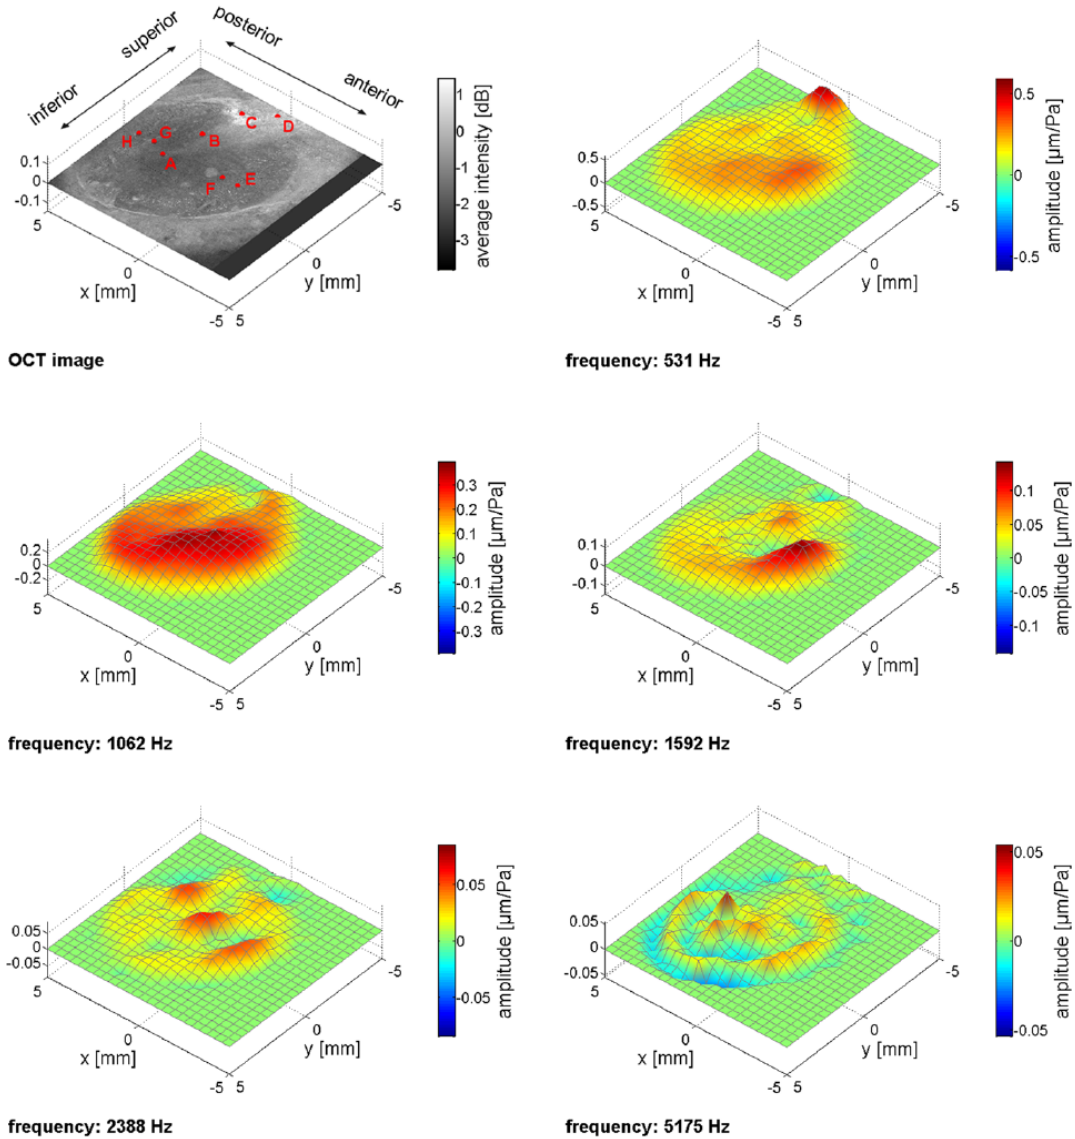
Figure 4. The upper left image shows the projection (average intensity) of the OCT stack. The quantitative evaluation in Figure 4 was carried out for the red marked points A–H. Point A represents the umbo, the line along A–B–C corresponds to the manubrium of malleus (MM), D indicates the pars flaccida, and E–F–A–G–H show the orientation perpendicular to the MM. The other images present the instantaneous displacement for five characteristic frequencies, where prominent patterns became visible. The scale of the patterns varies between each plot, because of a variation of the amplitude in the order of one magnitude over the whole frequency range. Reprinted with permission from Ref. [48] .